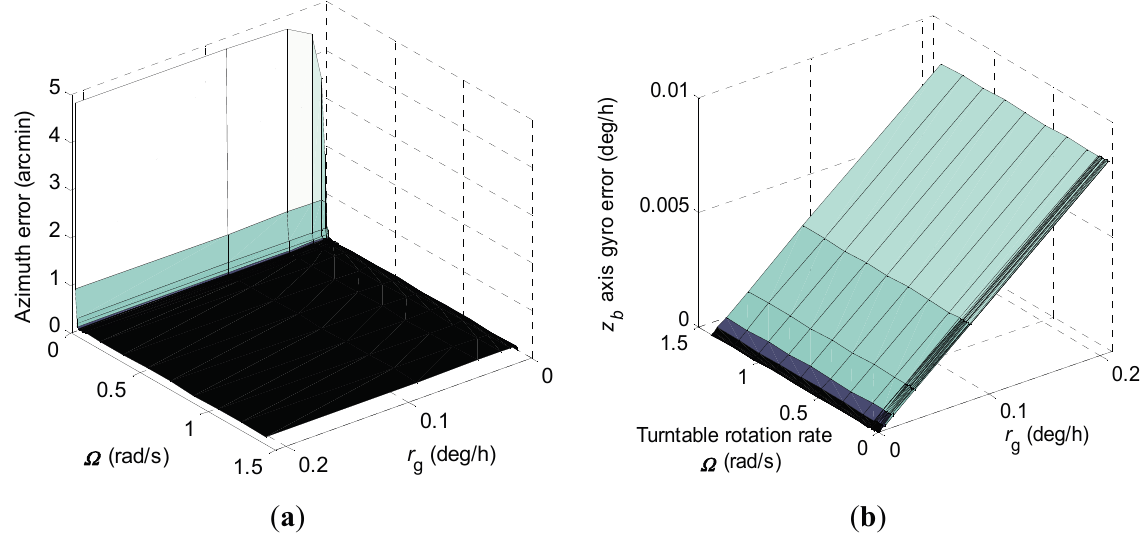
Figure 6. 1- σ values of final azimuth error and final z b axis gyro error at 600 s computed according to different turntable rotation rates and r g when using the constrained KF scheme. ( a ) Azimuth error; ( b ) z b axis gyro